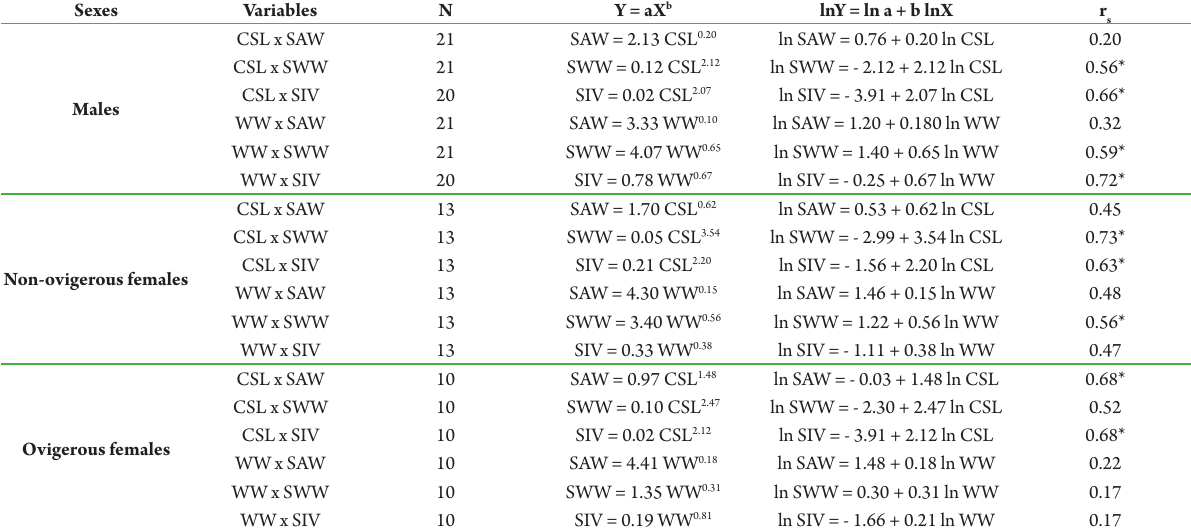
Table 6. Pagurus criniticornis. Regression equations for measures between hermit crab and the shells of Morula nodulosa chosen under laboratory conditions, according to sexes. (CSL = Cephalothoracic Shield Length; WW = hermit crab Wet Weight; SAW = Shell Aperture Width; SWW = Shell Wet Weight; SIV = Shell Internal Volume; N = number of individuals; rs = Spearman correlation